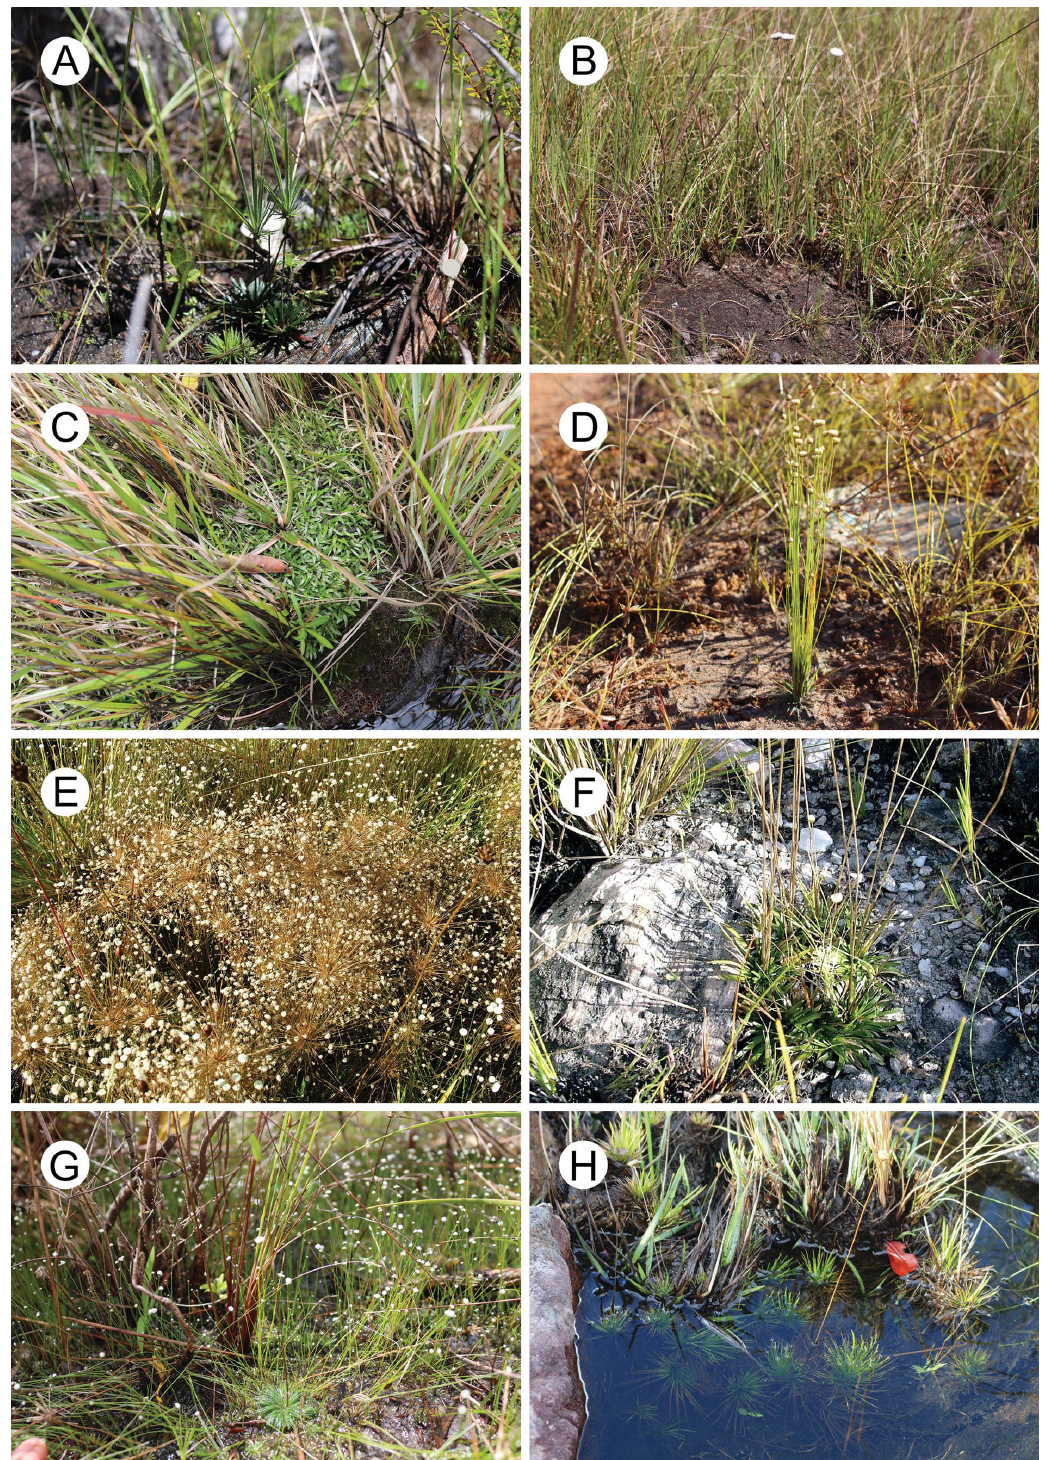
Fig. 10. Species of Paepalanthoideae (Eriocaulaceae) from the Chapada dos Veadeiros National Park. A . Syngonanthus densifolius var. brachyphyllus Moldenke . B . S. densifolius var. majus Moldenke